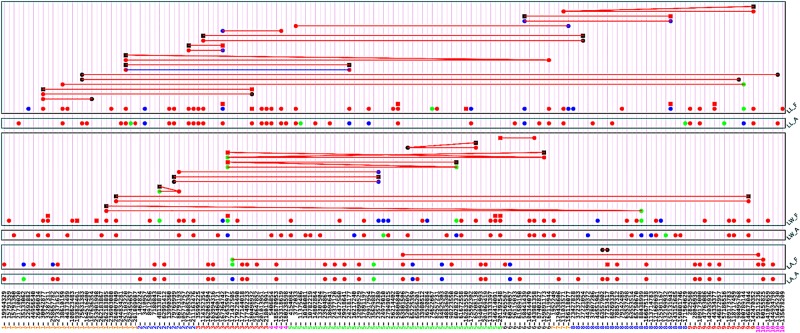
G×G plot of detected significant QTSs (PEW < 0.05) for three traits by using full model and additive model approaches. Circle: QTS with additive effect; square: QTS with dominant effect; line between two QTSs: epistasis effect; red color: QTS with general effects for two environments; green color: QTS with environment-specific effects; blue color: QTS with both general and environment-specific effects; black color: QTS with significant epistasis effects but without detected individual effects.